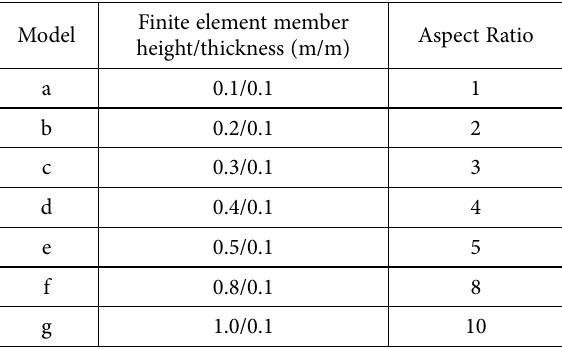
Fig. 5. Longitudinal moments for FEM models and SPM (Ex.1)